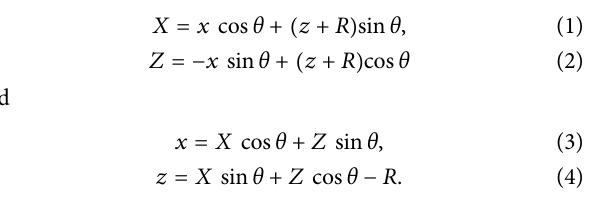
The periodic angular motion of the reactor on the vertical plane follows θ = θ 0 cos ( ω t ), where θ 0 is the maximal angular